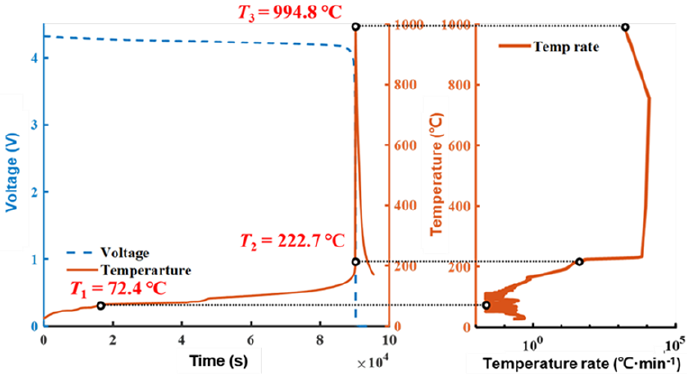
Figure 7. Internal temperature and voltage of the cell.